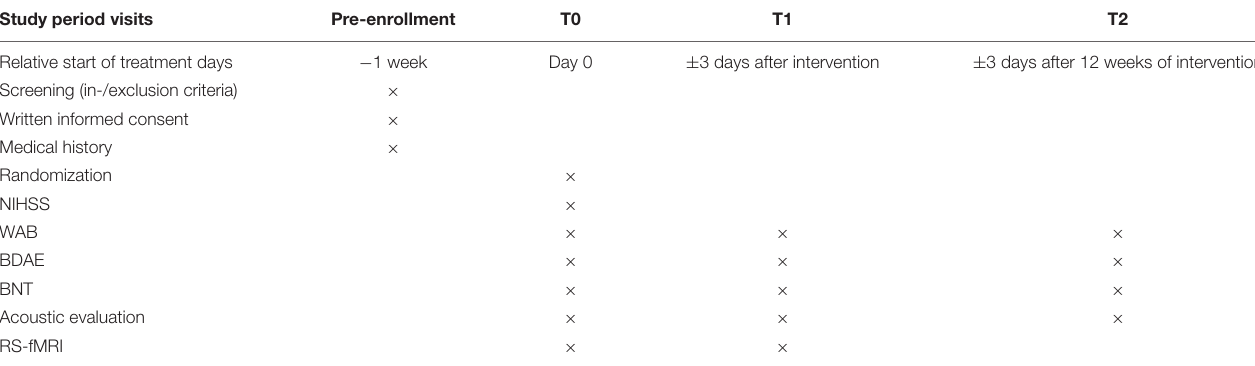
TABLE 1 | Overview of data collection and study